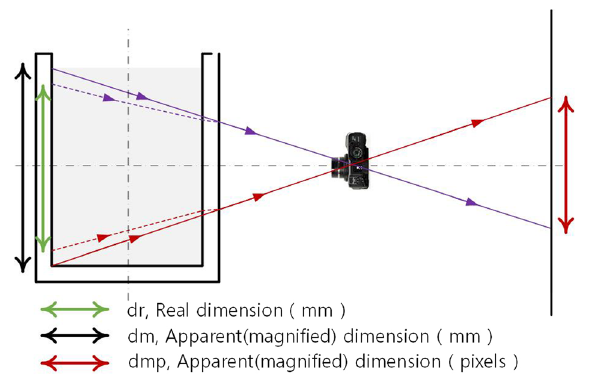
Figure 4. Effects of